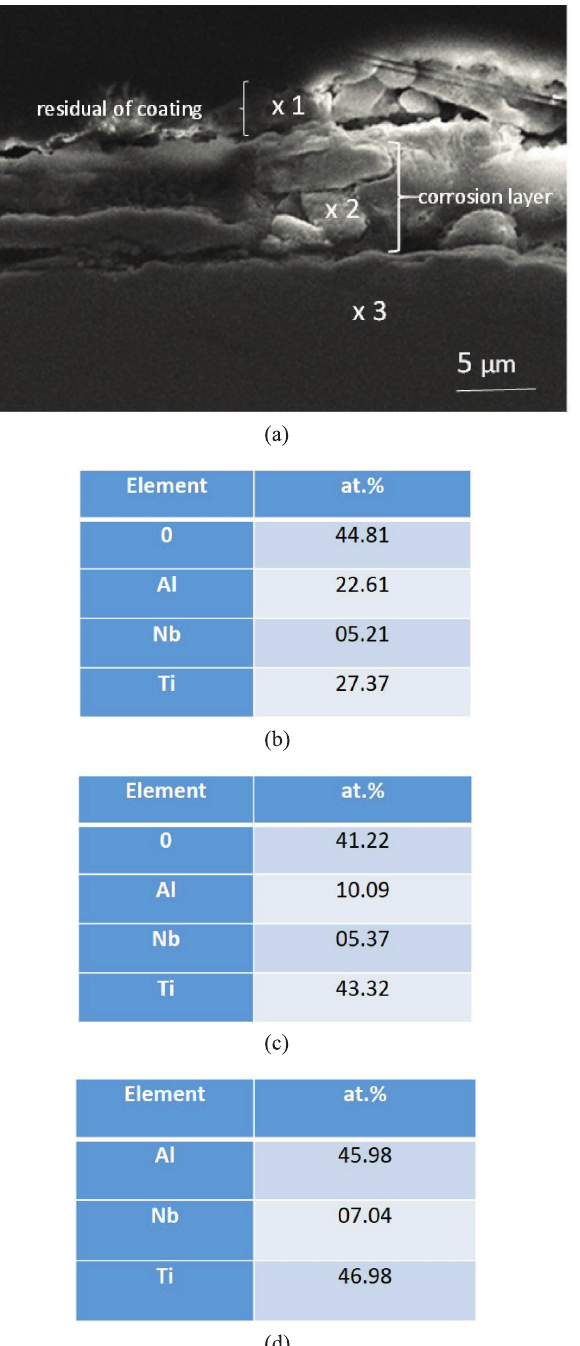
Fig. 8: (a) Cross-section of the scale formed on Ti-46Al-7Nb-0.7Cr- 0.1Si-0.1Ni coated with Al 2 O 3 after the oxidation in 9%O 2 +0.2%HCl+0.08%SO 2 +N 2 atmosphere, (b–d) chemical composition at points #1, #2 and #3